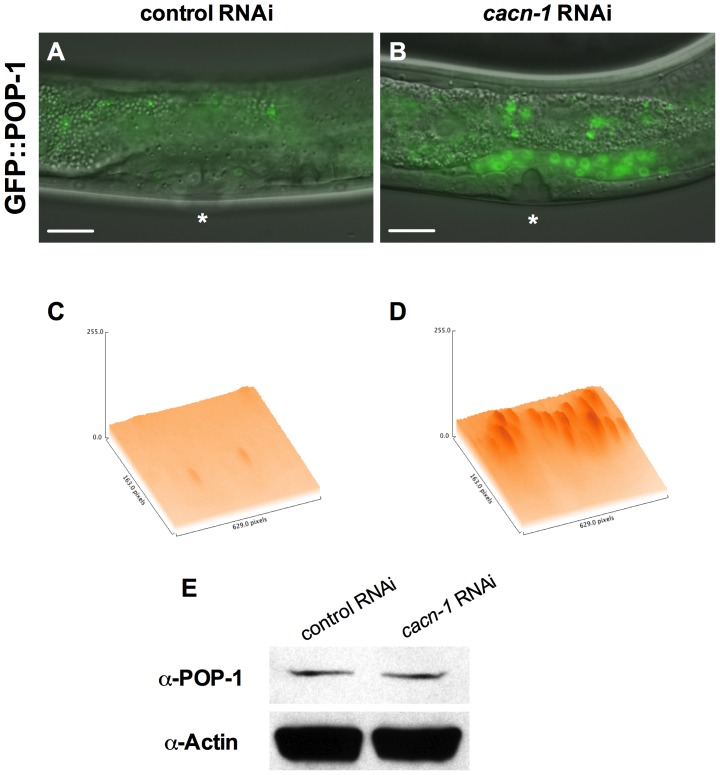
Loss of CACN-1 leads to nuclear accumulation of GFP::POP-1.
sys-1p::GFP::POP-1 animals were grown on E. coli HT115(DE3) carrying (A) control RNAi or (B) cacn-1 RNAi vector. Asterisks indicate L4 developing vulva. 3-dimensional representations of GFP expression with peak height corresponding to maximum intensity of fluorescent reporter in the uterus and vulva of (C) control RNAi or (D) cacn-1 RNAi treated animals (E) Western blots of extracts from control RNAi or cacn-1 RNAi-treated L4 animals probed with anti-POP-1 (94I) and anti-Actin antibodies. Scale bar is 25 µm.